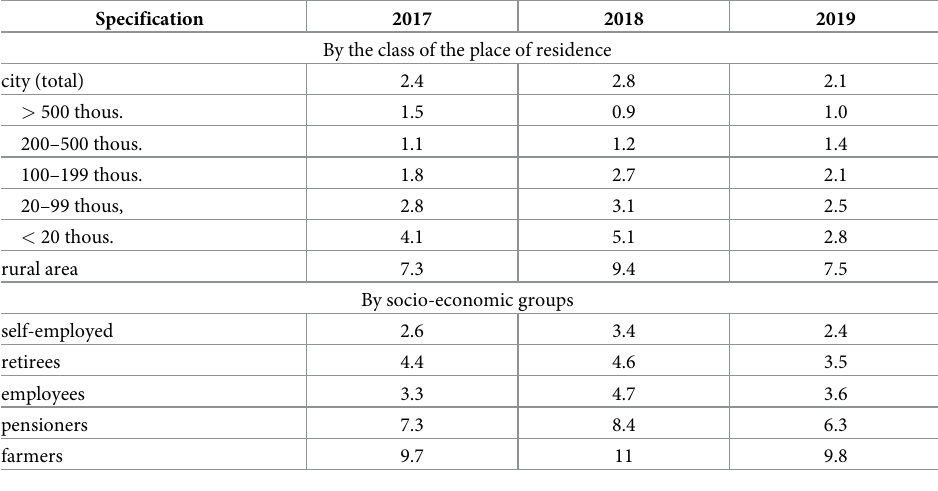
Table 1. The extent of extreme poverty in Poland in 2017–2019 (in% of people in